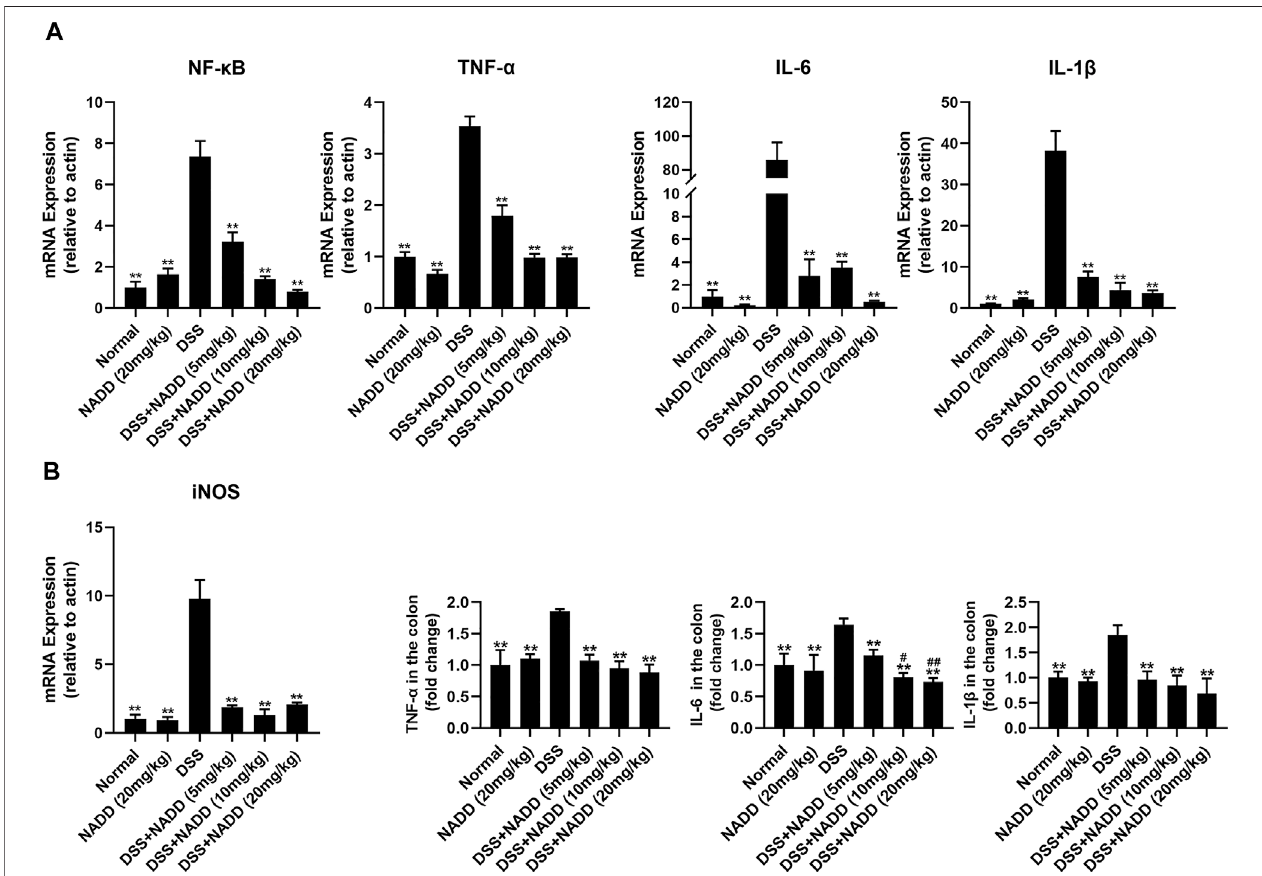
FIGURE 3 | Gene expressions and protein levels of proin fl ammatory factors. (A) mRNA expression levels of NF- κ B, TNF- α , IL-6, IL-1 β , and iNOS in colon tissues from mice in different treatment groups. (B) ELISA results of proin fl ammatory factor levels, including TNF- α , IL-6, IL-1 β , in colon tissues from mice in different treatment groups.Differenceswerestatisticallysigni fi cantwhencomparedwiththeDSSgroupmice( *p < 0.05, **p < 0.01),andcomparedwiththemicetreatedwithDSS+NADD (5 mg/kg) ( # p < 0.01, ## p < 0.01).